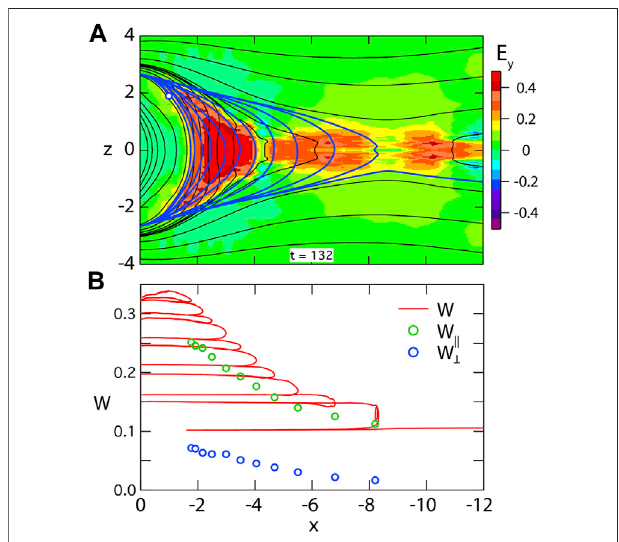
FIGURE 5 | Electron orbit contributing to the enhanced fi eld-aligned fl uxes at the PSBL location ( − 1, 0, 1.9), (A) projection of the orbit into the x , z plane superposed on the color-coded electric fi eld at t = 132, (B) particle energyasfunctionof x (redcurve)togetherwiththeparallel(greencircles) and perpendicular (blue circles) components at the equatorial